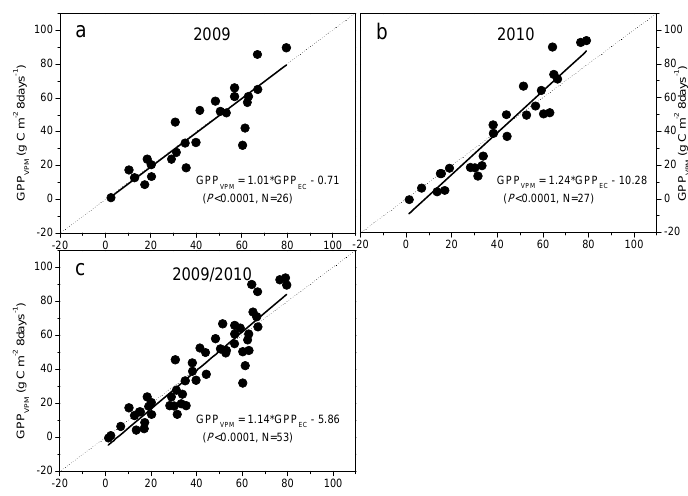
Figure 8. Linear regression analysis between the estimated gross primary production from EC tower (GPP EC ) and simulated gross primary production by VPM (GPP VPM ) in ( a ) 2009; ( b ) 2010; and ( c ) 2009–2010.